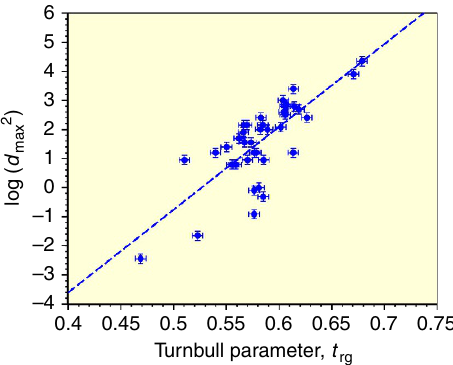
L ¼ 28.5 (cid:4) ln(10) B 66 of is suggestive (Note, the factor of t ln(10) arises from the present use of the log( d max 2 ) versus ln( d max 2 ) in ref. 24).